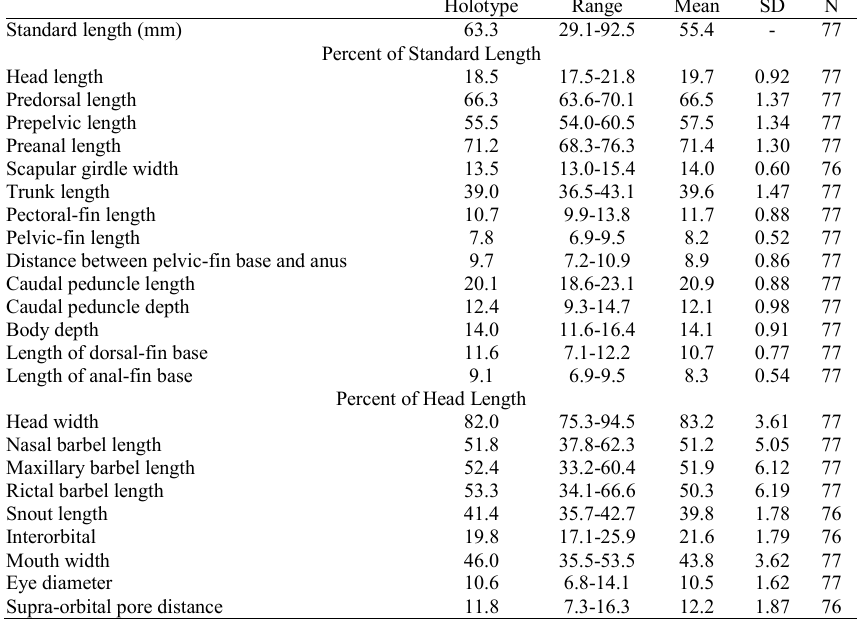
Table 3. Morphometric data for holotype and paratypes of Trichomycterus poikilos . SD = standard deviation; N = number of